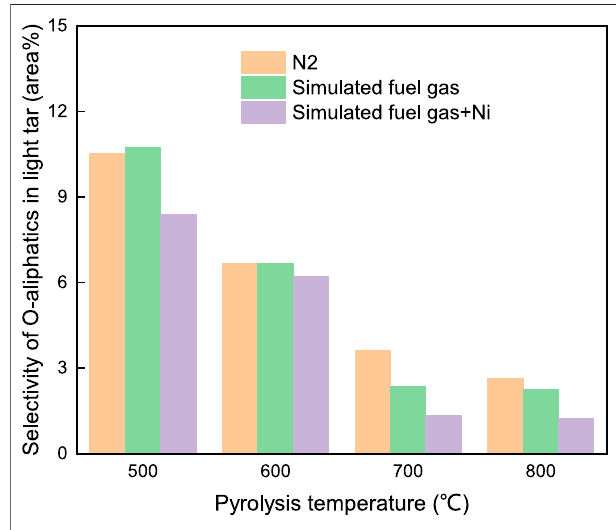
FIGURE 11 | The selectivity of the O-containing compounds under different atmosphere.